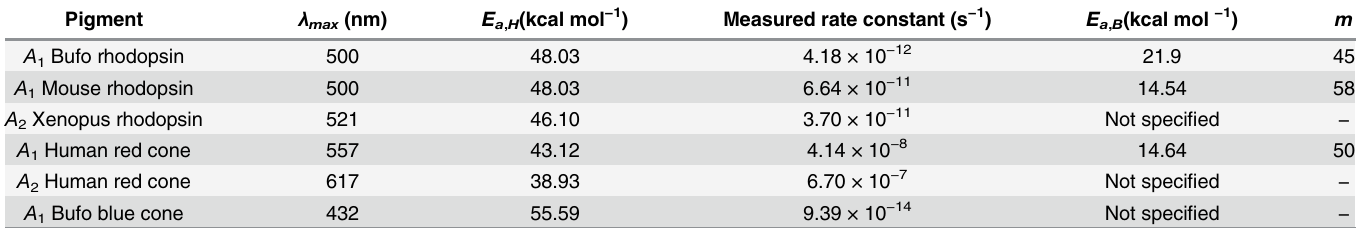
Table 1. The pigments given in the Luo et al ’ s work [2] have been revised based on the apparent thermal energy, E a , B , and the m value. It is seen that the A 1 Bufo rhodopsin and the A 1 mouse rhodopsin have similar λ max values ( λ max = 500 nm) while their E a , B were different. This causes a significant dif- ference in the m values. Another m value is obtained for the A 1 human red cone, which is again different than the ‘ exclusive ’ value m = 45. These results indi- cate that the m = 45 value is not a unique value for the all